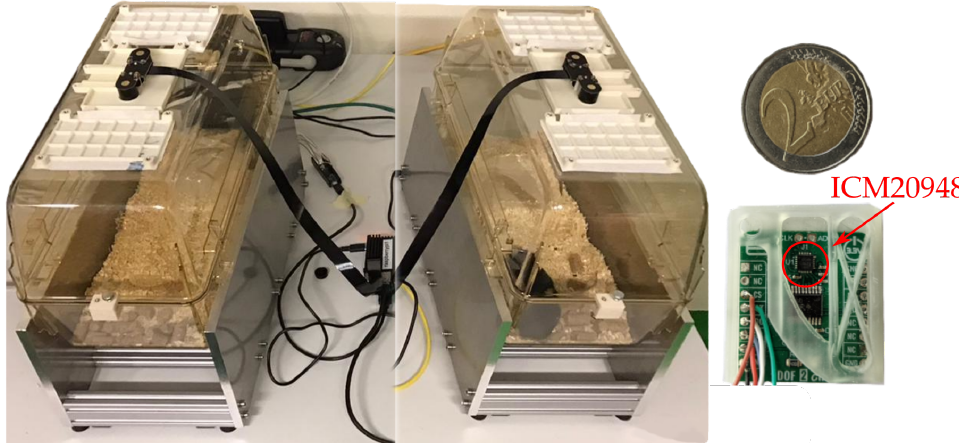
Figure 2. Figure shows the two measurement setups employed at the Institute for Laboratory Animal Science Aachen on the left. One the right the ICM20948 [27] is shown with a 2 Euro coin as reference for